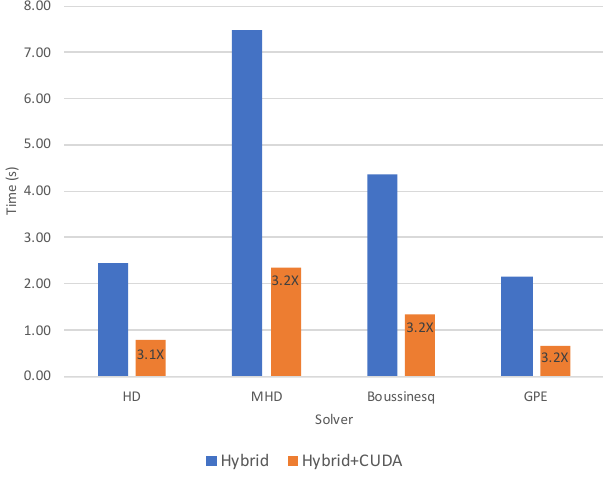
Figure 7. Bar plot of the total time per time step (for the full CFD code) in CPU-only and GPU runs for each of four solvers on an isotropic grid of 512 3 points with 4 nodes, 4 MPI tasks and GPUs per node, and 4 threads per MPI task. The speed-up of the GPU runs for each solver is indicated in the runtime bar for the GPU